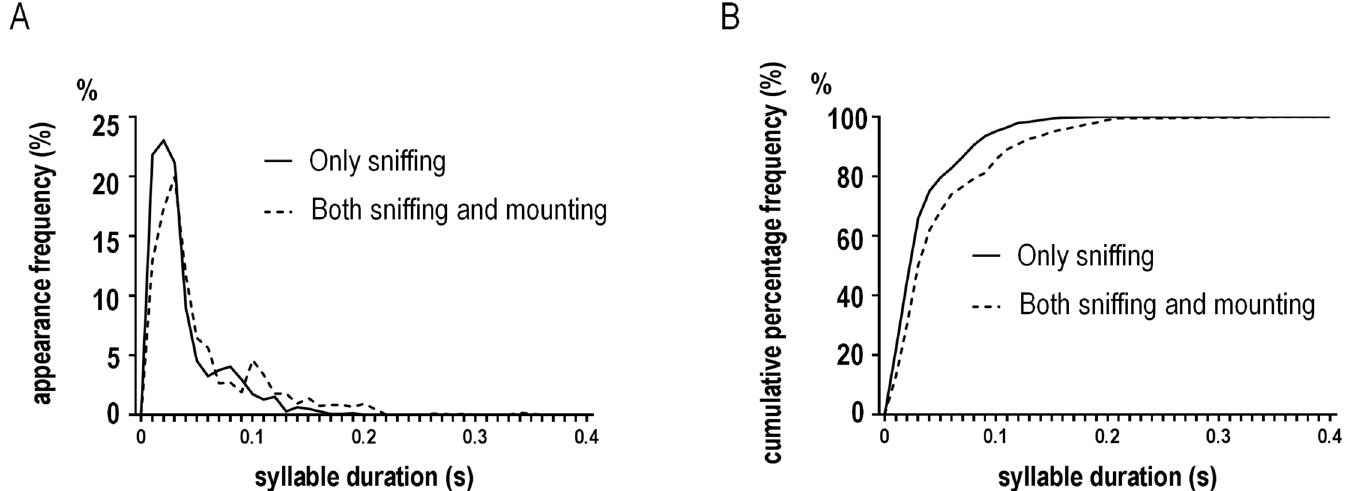
Fig 7. The difference in syllable duration associated with later behavior. Distribution (A) and cumulative percentage (B) of syllable duration during vocalizations in the early phase, between mice that exhibited only sniffing (continuous line) and mice that exhibited both sniffing and mounting behavior (dashed line) over the course of the interaction. Both groups of animals displayed only sniffing behavior in the early phase. The differences between these groups were significant ( p < 0.01).